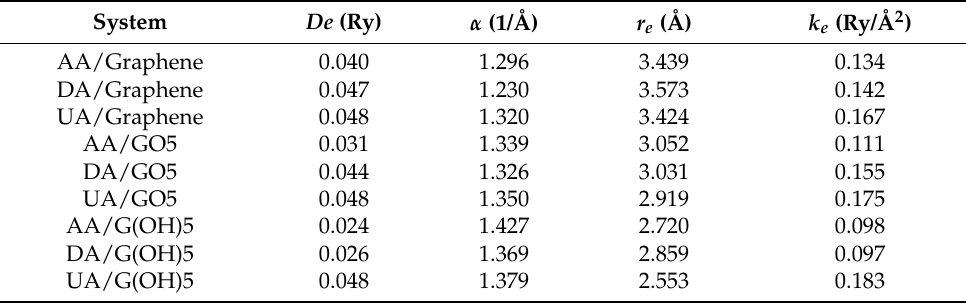
Figure 3. Optimized configurations and 0.005 e/Å 3 iso-density surfaces of the ( a ) AA/graphene, ( b ) DA/graphene, ( c ) UA/graphene, ( d ) AA/GO5, ( e ) DA/GO5, ( f ) UA/GO5, ( g ) AA/G(OH)5, ( h ) DA/G(OH)5, and ( i ) UA/G(OH)5 systems. Atom groups with highest positive partial charge are labeled by ‘***’ and the adsorption energy from the Morse potential fitting is given for each system. Table 3. Morse potential fitting parameters of AA, DA, and UA adsorption obtained from the calculated potential energy as functions of distances from the pristine graphene, GO5 and G(OH)5